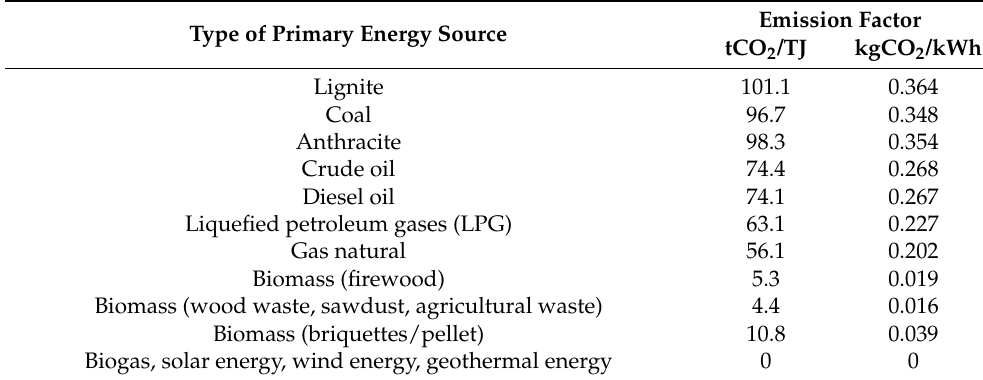
Table 1. Greenhouse gas emissions coefficients by primary energy sources (CO 2